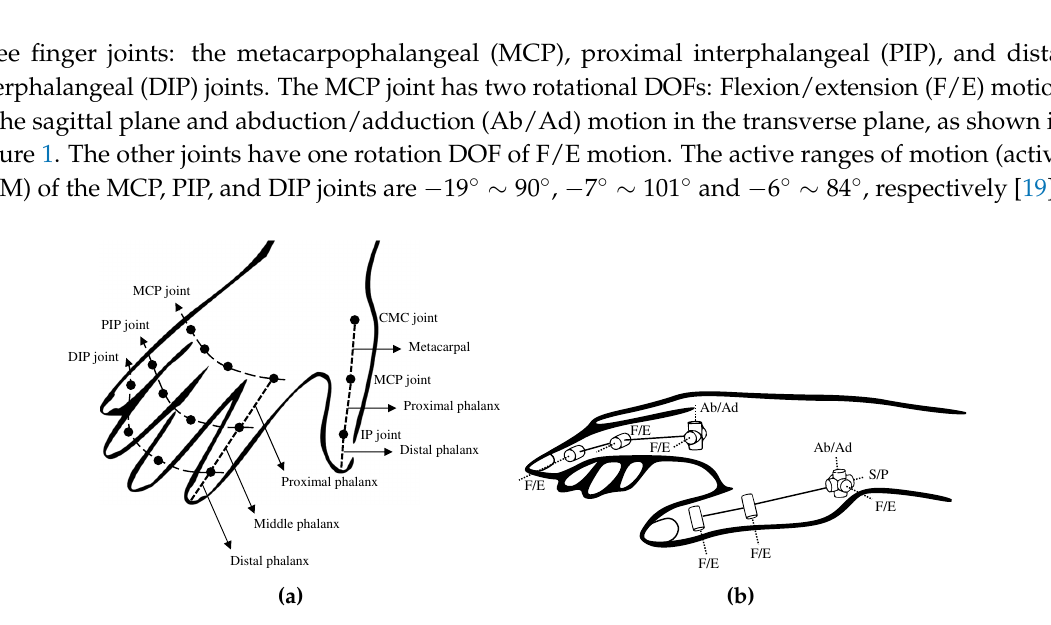
Figure 1. Schematics of the hand model; ( a ) Hand anatomy; ( b ) Hand biomechanical model. The thumb has the metacarpal bone, proximal, and distal phalanges. The MCP joint has two DOFs of F/E and Ab/Ad, but Ab/Ad motion is dependent on the motion of carpometacarpal (CMC) joint [20]. The metacarpal allows for three-dimensional rotation at the CMC joint beside the wrist. The CMC joint is considered to be best modeled as a two DOFs joint, with F/E and Ab/Ad axes that are non-orthogonal and non-intersecting [17,21,22]. However, if orthogonal intersecting axes are considered, a third longitudinal axis for S/P motion should be considered [23,24]. In this paper, we set the biomechanical model of the thumb as shown in Figure 1b. The CMC joint has three orthogonal axes of F/E, Ab/Ad, and S/P, and the directions of F/E and Ab/Ad axes are the same as those axes of MCP joint of the index finger. In Figure 1b, the CMC joint is slightly rotated in the direction of F/E and Ab/Ad